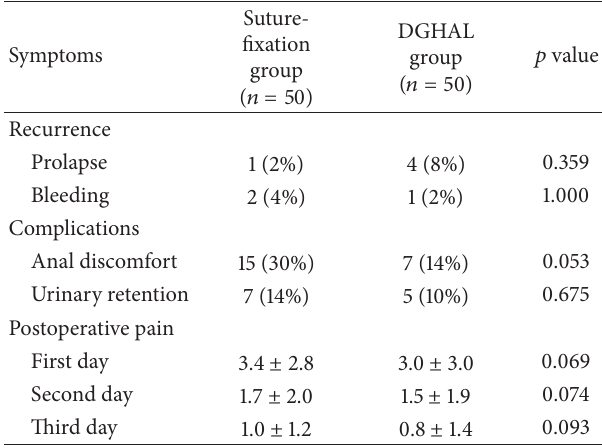
Table 2: Short-term recurrence of symptoms, postoperative com- plications,andpostoperativepainscore(visualanaloguescale,0–10) between the two